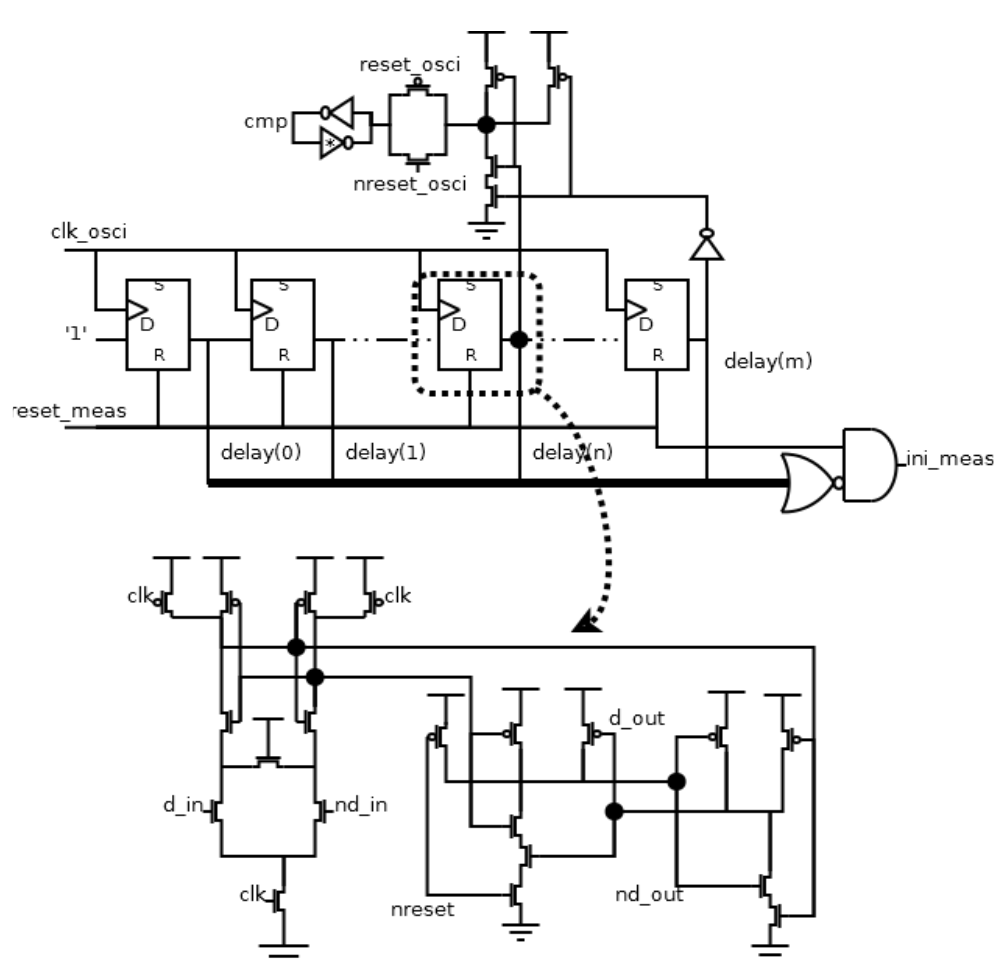
Figure 6. Implementation of the measurement